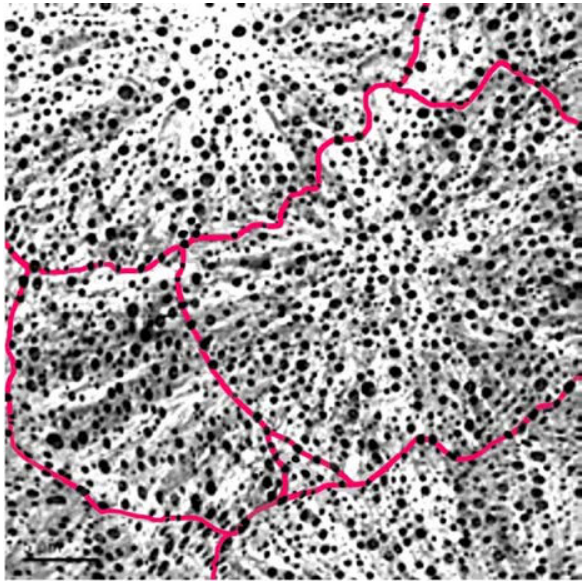
Figure 9. TEM picture of iPP/m-EPR1 80/20 with marked spheru- lites boundaries indicating intraspherulitical besides